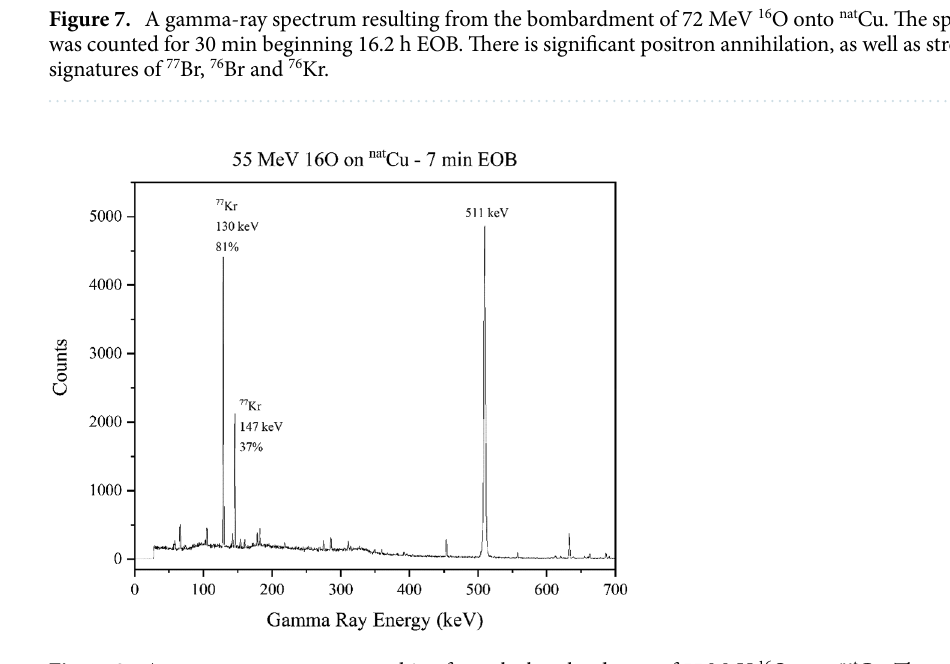
Figure 8. A gamma-ray spectrum resulting from the bombardment of 55 MeV 16 O onto nat Cu. The spectrum was counted for 1 min beginning 7-min EOB. There is significant positron annihilation, as well as strong signatures of 77